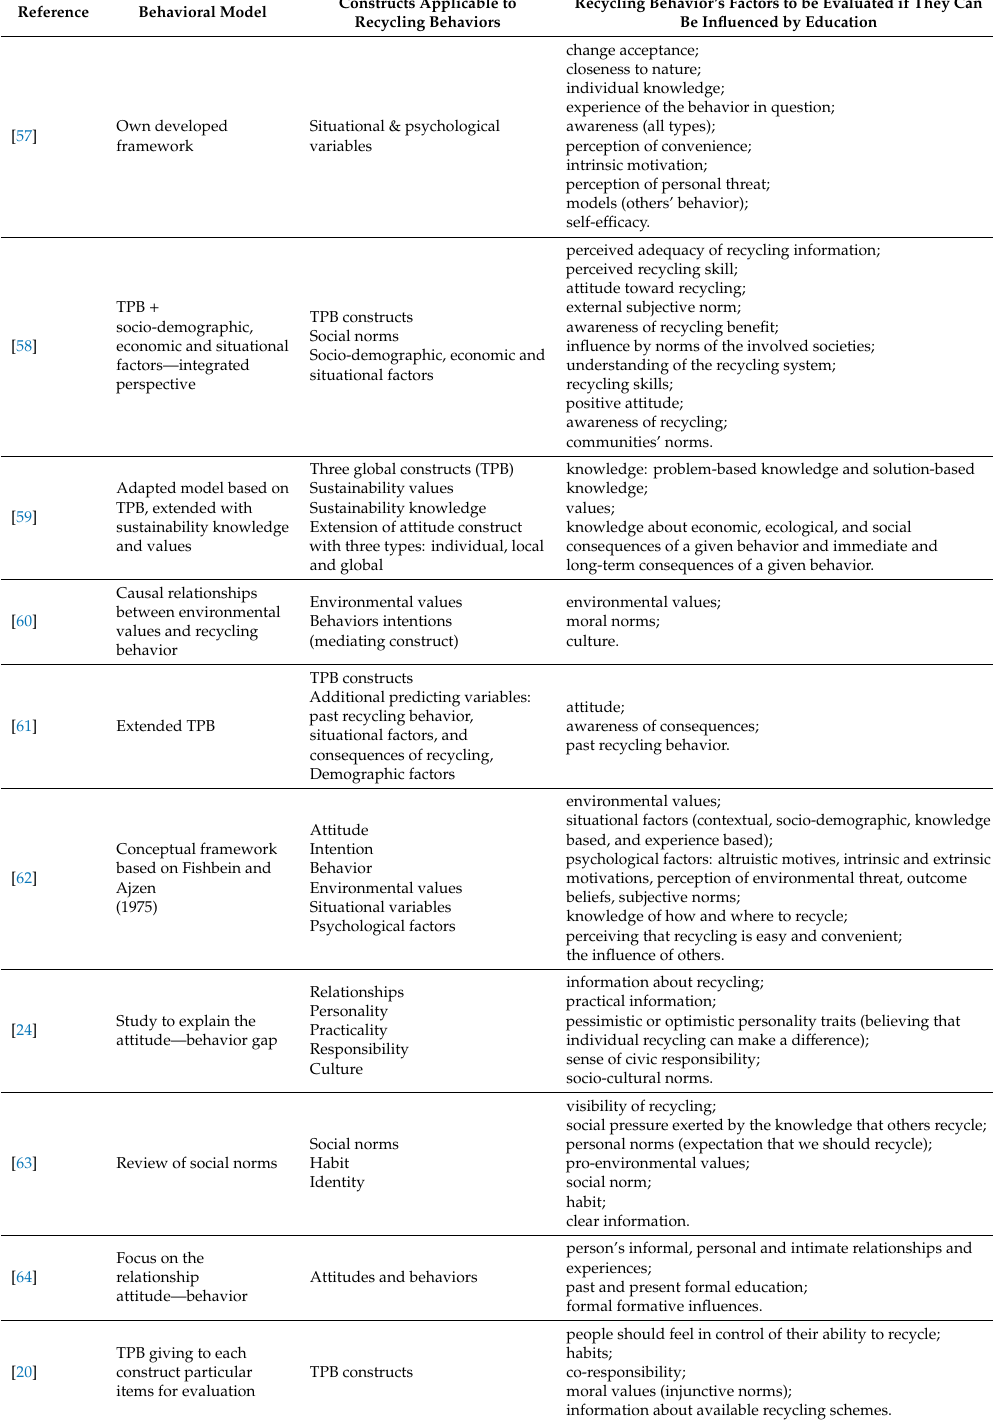
Table 2. Recycling behavioral constructs and factors which can be influenced by education.